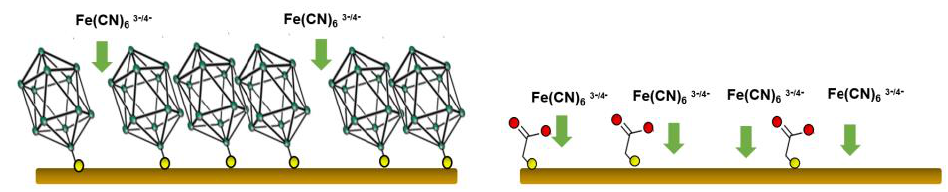
Scheme 3. Equivalent circuit used for fitting EIS Scheme 2. Representation of the blocking effect of the [B 12 H 11 S-Au] 2 − and Au-(TGA) assemblies.